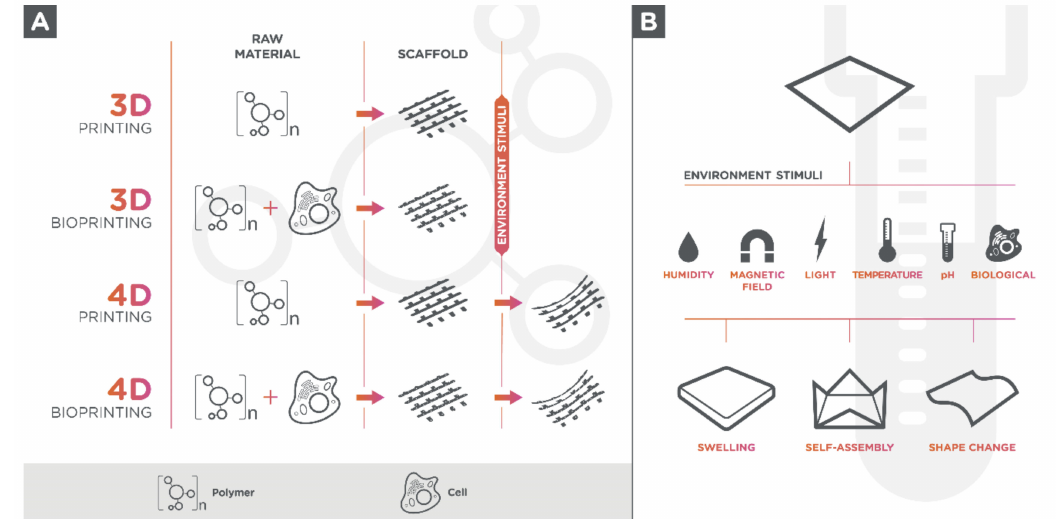
Figure 1. ( A ) Schematic of the different 3D or 4D printing technologies using conventional or smart materials for cell-free or cell-laden (Bioprinting) scaffolds production. Smart materials scaffolds can change their size, shape, and/or functionality in response to one or more stimulus; ( B ) types of environment stimuli and responses observed in dynamic smart